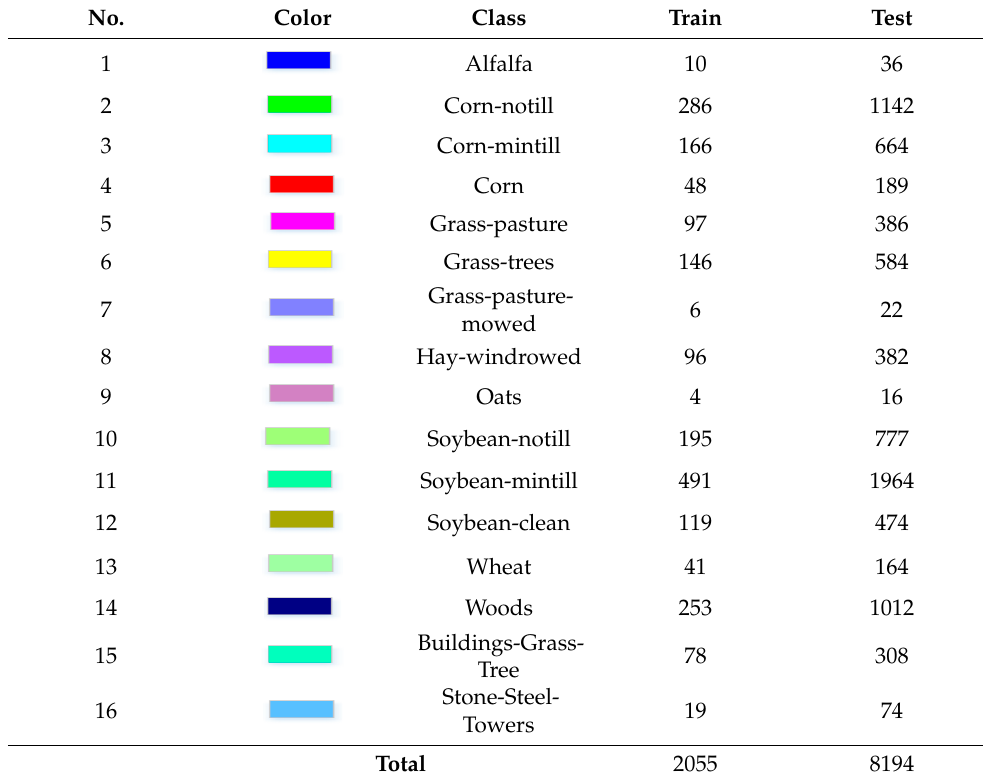
Table 4. Number of training and test samples of SA dataset.